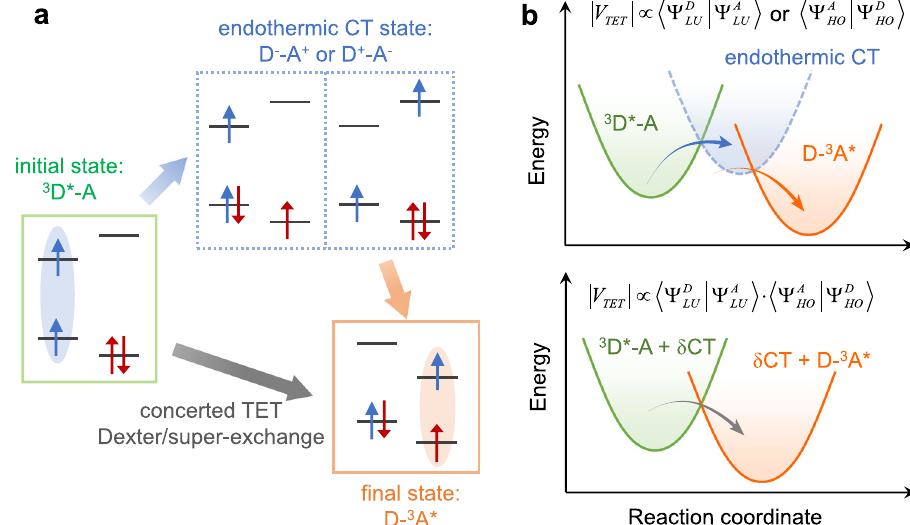
Fig. 1 Concerted versus endothermic CT-mediated TET. a Schematic depiction of the initial and fi nal states and intermediate endothermic CT states. 3 D*-A and D- 3 A* are the initial and fi nal states, respectively, whereas D − -A + and D + -A − are the possible endothermic charge-transfer (CT) states. The red and blue arrows indicate the spins of the electrons in the donor and acceptor, respectively. b Concerted (lower) versus endothermic CT-mediated (upper) TET mechanisms drawn in reaction coordinate diagrams. Note that, although not considered in Dexter ’ s original formula, the initial and fi nal states in concerted TET could be mixed with virtual CT states (super-exchange). The electronic coupling matrix elements (| V TET |) for concerted and endothermic CT-mediated TET are expressed in terms of donor and acceptor wavefunctions, where D and A stand for donor and acceptor and LU and HO stand for lowest unoccupied and highest occupied molecular orbitals,